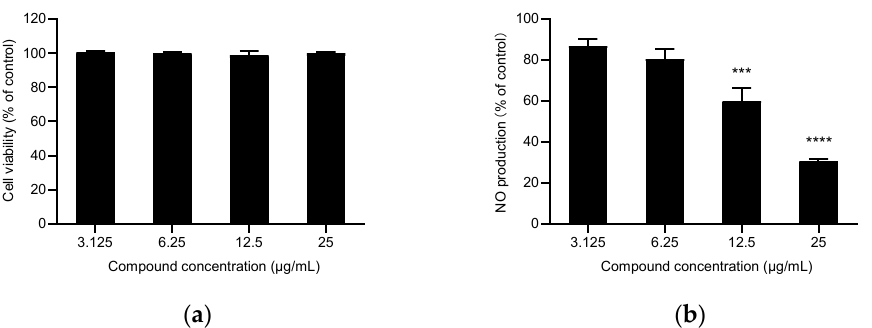
Figure 2. Anti-inflammatory activity of the essential oil of Z. acanthopodium fruits from Myanmar (EOZC). ( a ) The cytotoxicity of EOZC in RAW 264.7 cells. Cell viability were by MTS assay. ( b ) The inhibitin of EOZC on LPS-induced NO produc-tion in RAW 264.7 cells. Results were presented as mean ± standard deviation (SD) of three independent tests, *** p = 0.002, **** p < 0.0001. Table 3. Anti-inflammatory activity of essential oils from Z. acanthopodium fruits . Compound